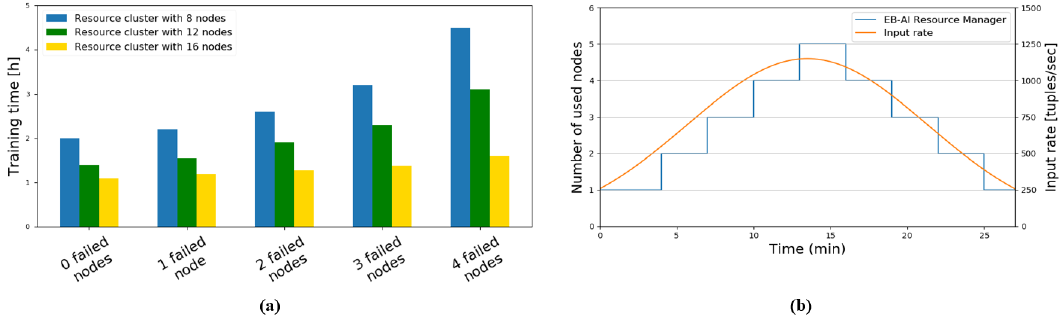
Figure 8. Usage of training resources in the context of fault tolerance and elastic scalability. ( a ) Fault tolerance based on number of failed nodes. ( b ) Elastic scalability of the EB-AI Resource